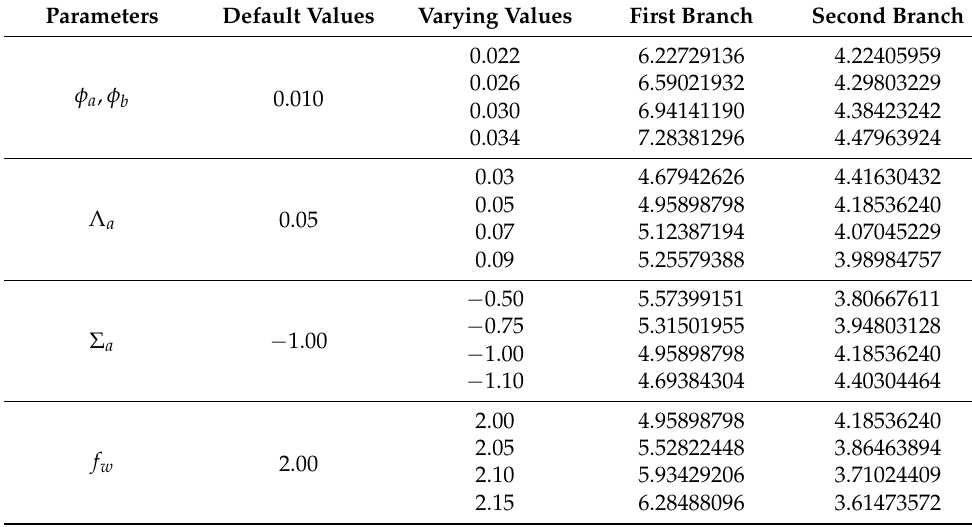
Table 3. Numerical values of the quantity C f towards the variation in the pertinent flow parameters for both the FBS and SBS